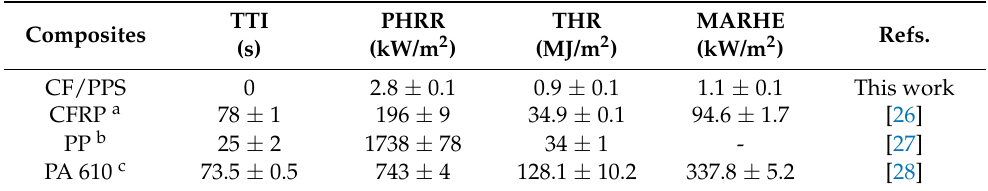
Table 4. Cone calorimeter test results of CF/PPS and other composites (processing temperatures of 280 ◦ C).